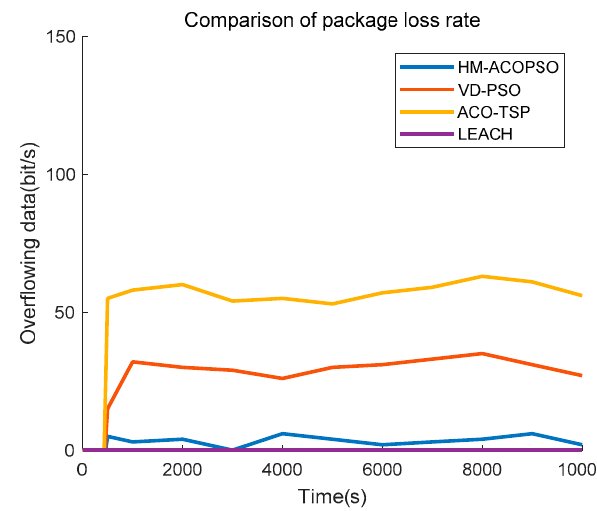
Figure 11. Overflowing data of the network.